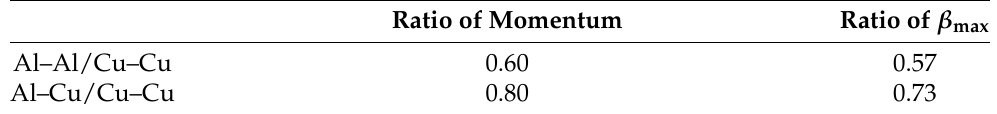
Table 2. Ratios of the momentum and upper boundary angle β max of Al–Al and Al–Cu related to Cu–Cu. The calculation of the momentum is listed at Appendix C. The upper boundary angle was calculated by the equations in Appendix